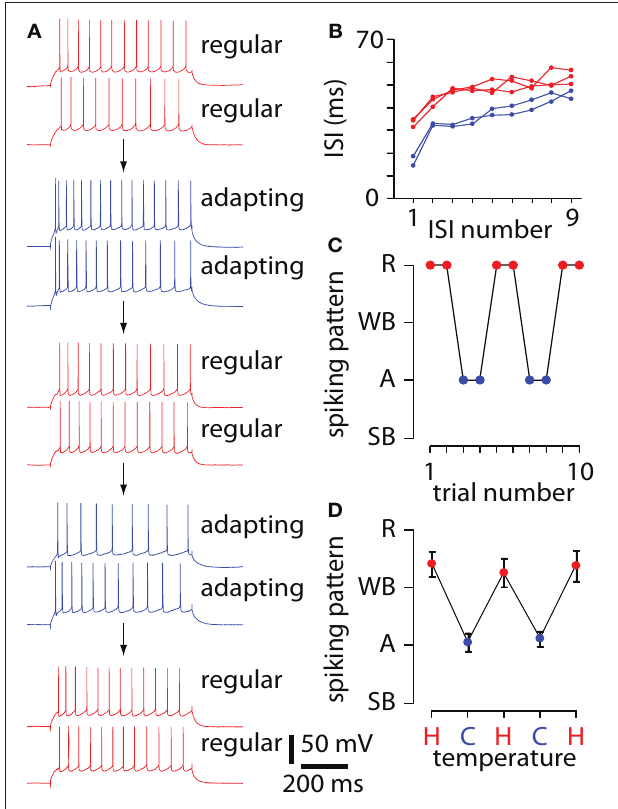
FIGURE 3 | Reversibility of the effect of temperature on spiking pattern. (A) Voltage recordings from a layer 6 pyramidal neuron, showing spiking patterns in a series of trials, during which temperature was repeatedly cycled from 35–37 ◦ C (red) to 24–26 ◦ C (blue) and back to 35–37 ◦ C. Trials are displayed in order of acquisition, from top to bottom. Spiking pattern was stable at 24–26 ◦ C (blue) and at 35–37 ◦ C (red), but switched between regular and adapting spiking patterns with temperature. (B) The first nine inter-spike intervals (ISIs) for the first of each pair of trials at 24–26 ◦ C (blue) and at 35–37 ◦ C (red), illustrating the reproducible and reversible change in spiking pattern. (C) Summary of the changes in spiking pattern for the 10 trials in panel A . (D) Mean ± SEM spiking patterns for 10 layer 6 pyramidal neurons, showing reproducible changes in spiking pattern with repeated cooling and reheating cycles. Each point is the mean of 3 trials in each neuron, with n = 10, 10, 9, 5, and 5 neurons contributing to the five points.